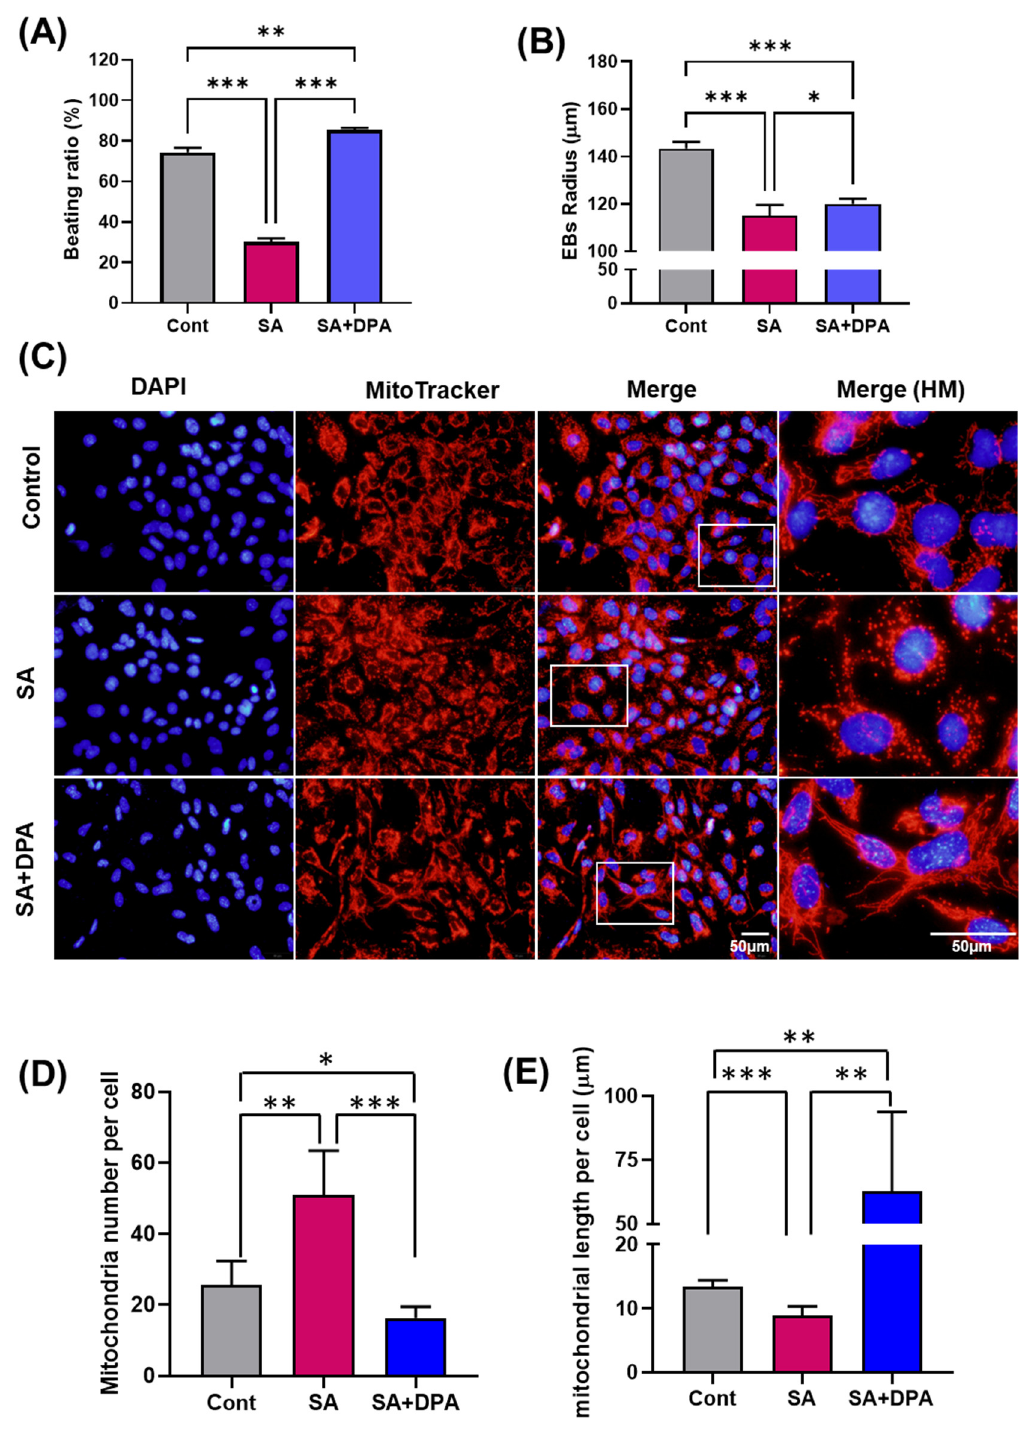
Figure 4. Effect of D-penicillamine against sodium arsenite during cardiac differentiation. The effect of D-penicillamine (DPA) against the interruption of cardiac differentiation by sodium arsenite (SA) exposure was measured, and the mitochondria morphology was analyzed in EB. ( A , B ) are bar graphs of beating ratio and EB size. ( C ) Representative pictures of mitochondria. Mitochondria (39) were stained with MitoTracker, and the nuclei (blue) were stained with DAPI. ( D , E ) are the bar graphs of the number of mitochondria in each cell and the mitochondria length (n > 50 cells). The significance was obtained using a Tukey’s test. * p < 0.01, ** p < 0.01, *** p < 0.0001 vs. control. Each value is expressed as the means ± SD. Cont; control.